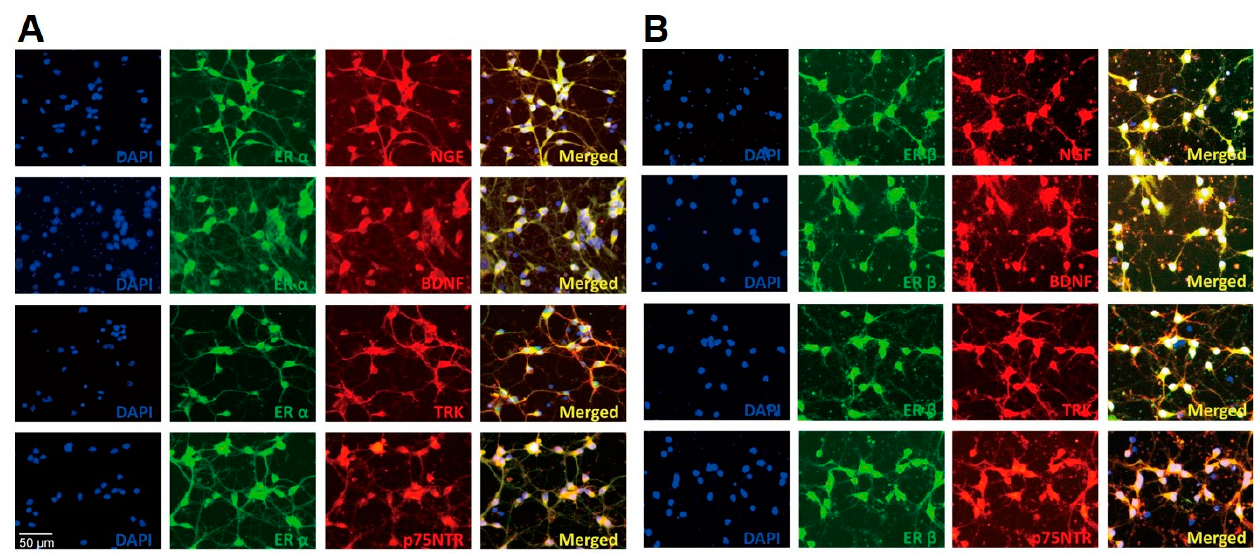
Figure 2. Localization of estrogen receptor (ER) α ( A ) and β ( B ) with NGF, BDNF, TRK, and p75NTR in primary forebrain neuron.